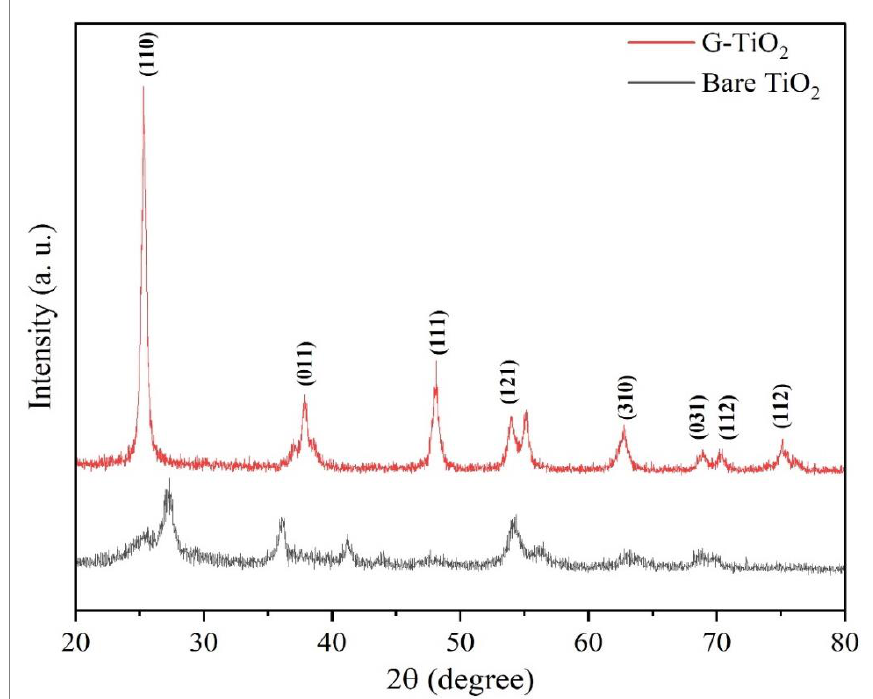
Figure 3. XRD spectra of biosynthesized and bare TiO 2 nanoparticles.